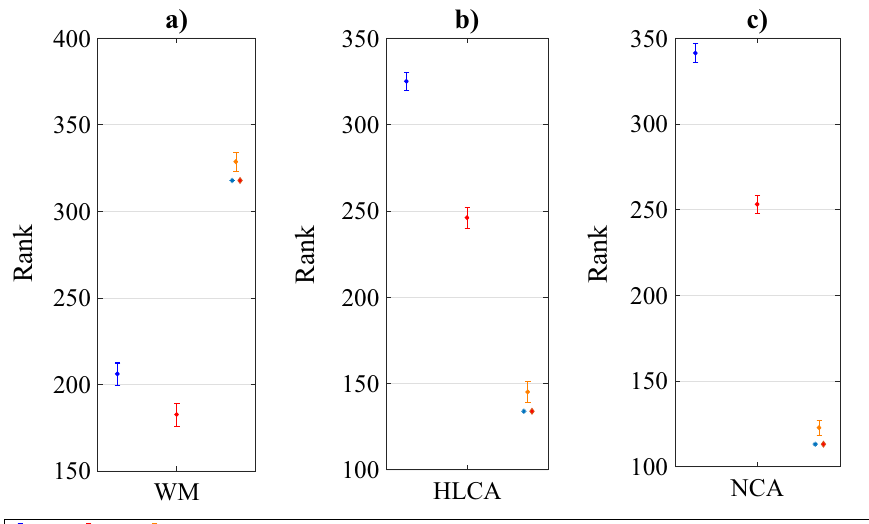
Figure 5. Summary of the post-hoc Kruskal–Wallis test of the survey questionnaire. The mean rank of each group is plotted for each part of the test with the corresponding standard deviation considering the all bootstrapping iterations. ( a ) Second part of the test in which the attention of the participant is not focused on one arrow in particular. WM: weirdness motion. ( b ), ( c ) Third part of the test in which the participant is focused on the circled arrow. HLCA: human-likeness of the circled arrow; NCA: naturalness of the circled arrow. HO: video with humans only; GT: video with humans and a robot driven by our game-theoretical trajectory planner; VFH: video with humans and a robot driven by the Enhanced Vector Field Histogram algorithm. The blue asterisk highlights the statistical difference from HO, while the red diamond highlights the statistical difference from GT.